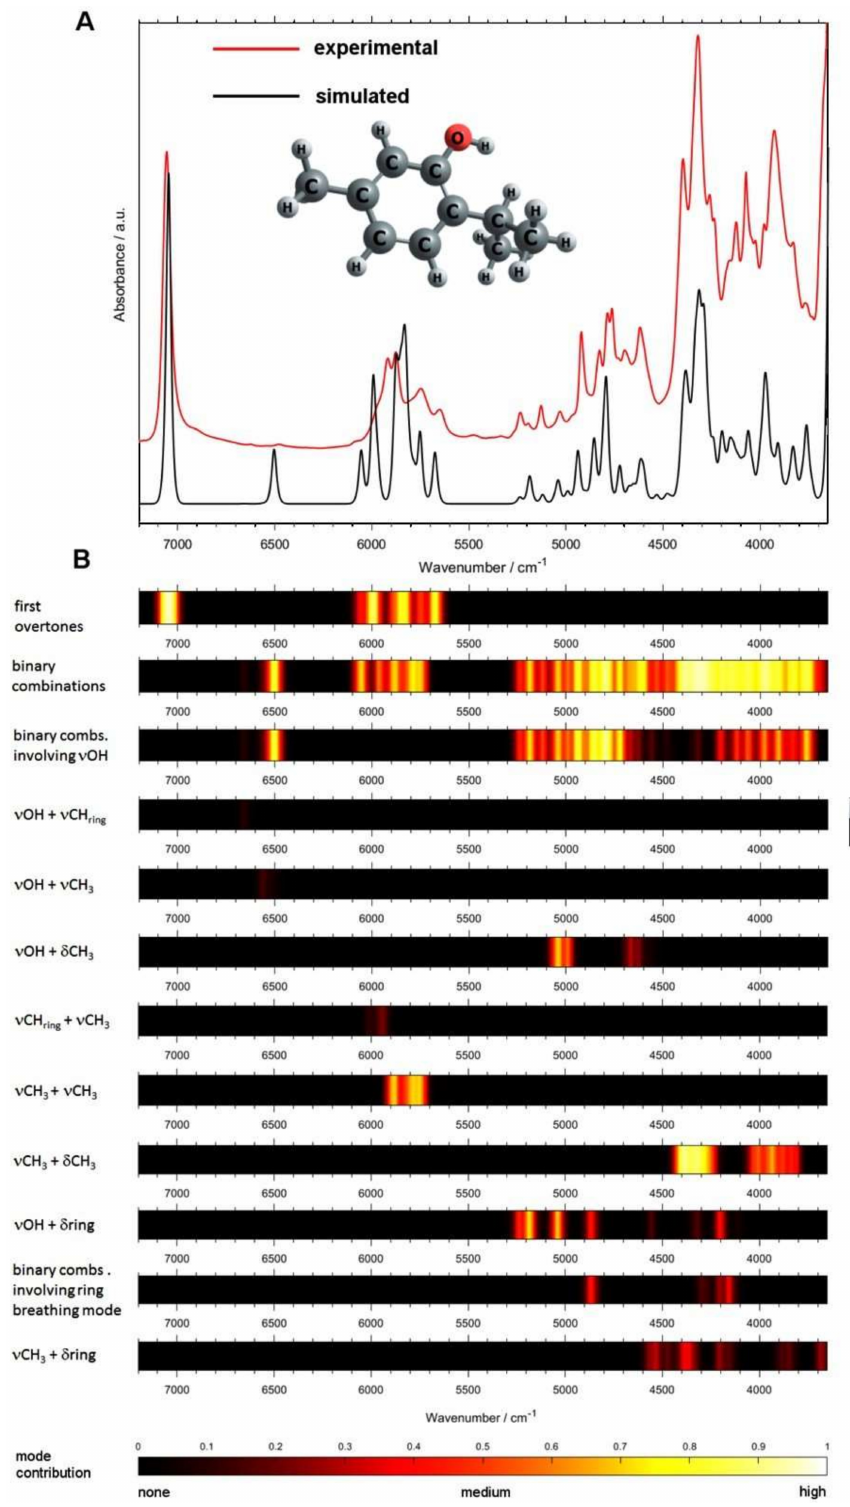
Figure 12. The analysis of mode contribution for the NIR spectrum of thymol (solution; 100 mg mL − 1 CCl 4 ) based on the simulated data. ( A ) Experimental and simulated outlines. ( B ) Contributions of selected modes as described on the figure. Reproduced with permission from Ref.